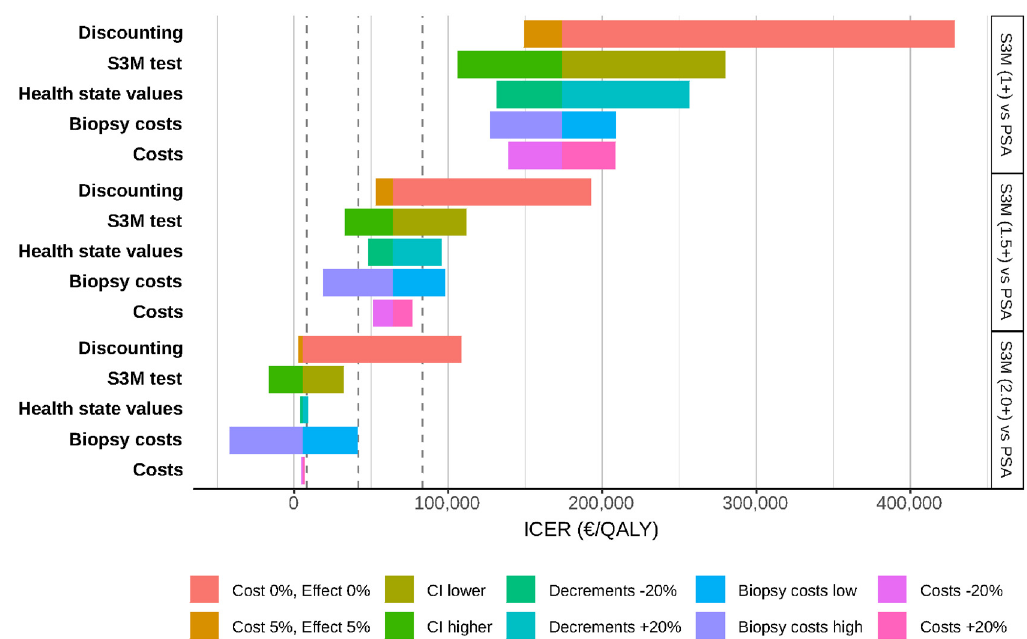
Fig 4. One-way sensitivity analysis showing the effect of no and high discounting rates, the S3M test performance, high and low biopsy costs, 20% variation in all costs and health state value decrements on the cost-effectiveness. From the left, the dashed lines show the limits for low (less than € 8,300), moderate ( € 8,300–41,600), high ( € 41,600–83,300), and very high costs (over € 83,300) for Sweden. The bounds for the biopsy costs, together with the urology assessment, varied between € 330 and €